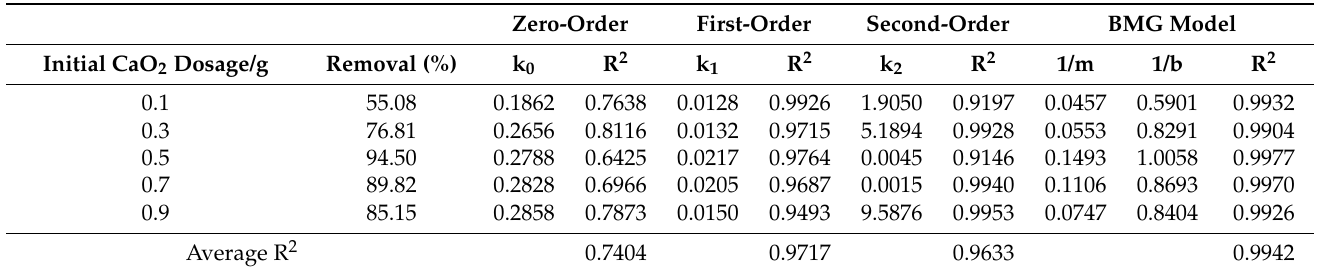
Table 5. Comparison of kinetic models at different initial CaO 2